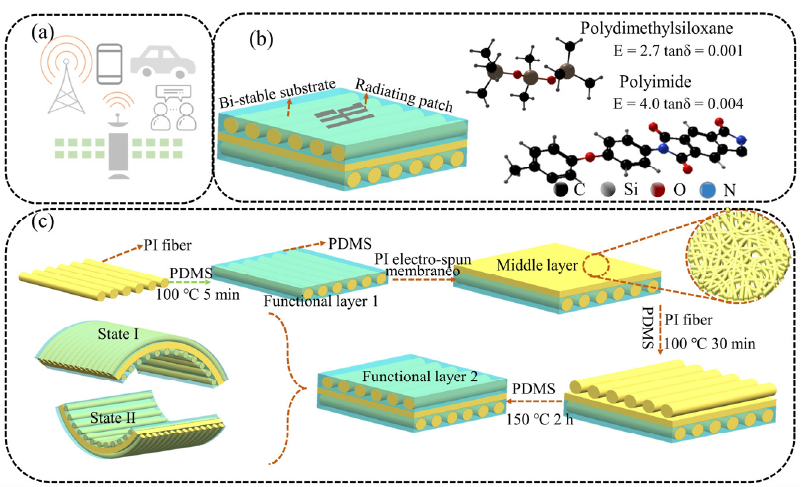
Figure 1. ( a ) Schematic of the potential applications of flexible film antennas. ( b ) Structural schematic of a micro-strip antenna. ( c ) Design and preparation of a reconfigurable substrate with bi-stable characteristics .